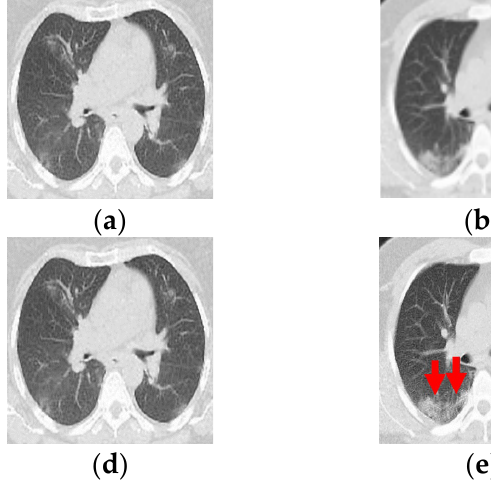
Figure 1. ( a – c ) Computed tomography from a patient with COVID-19. ( d – f ) Ground-glass opacity identification (red arrow marking) for three-class damage progression classification: ( d ) Class 1, ( e ) Class 2, and ( f ) Class 3.